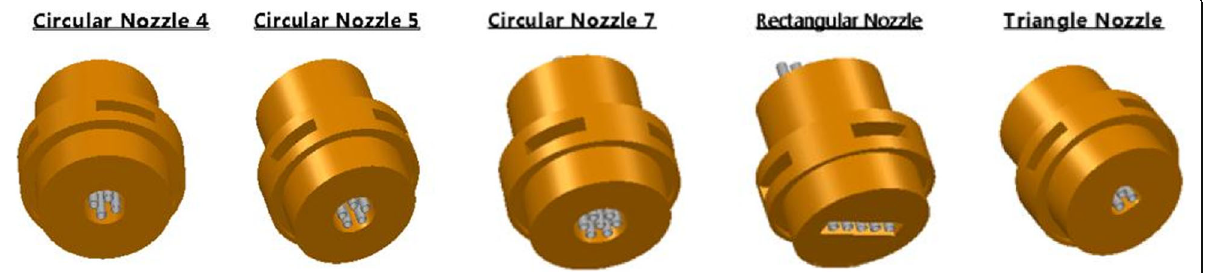
Fig. 3 Detailed mechanical drawing of all nozzles (all dimensions in